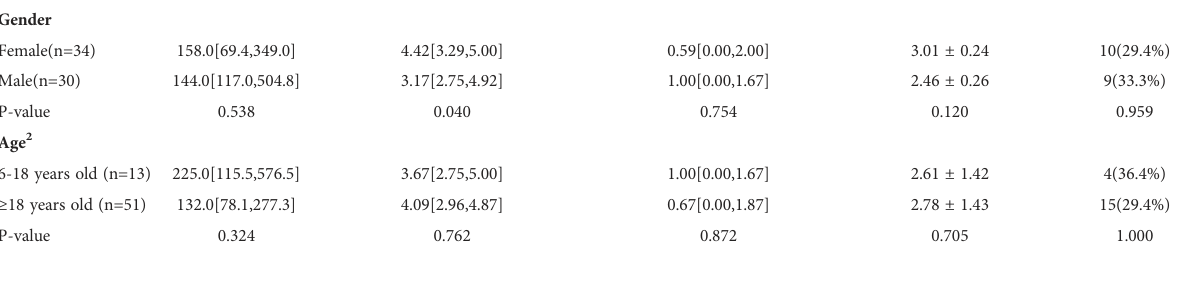
TABLE 4 In fl uence factor analysis about ef fi cacy of preventative omalizumab. Table 4A In fl uence of demographic factors. tIgE(KU/L)